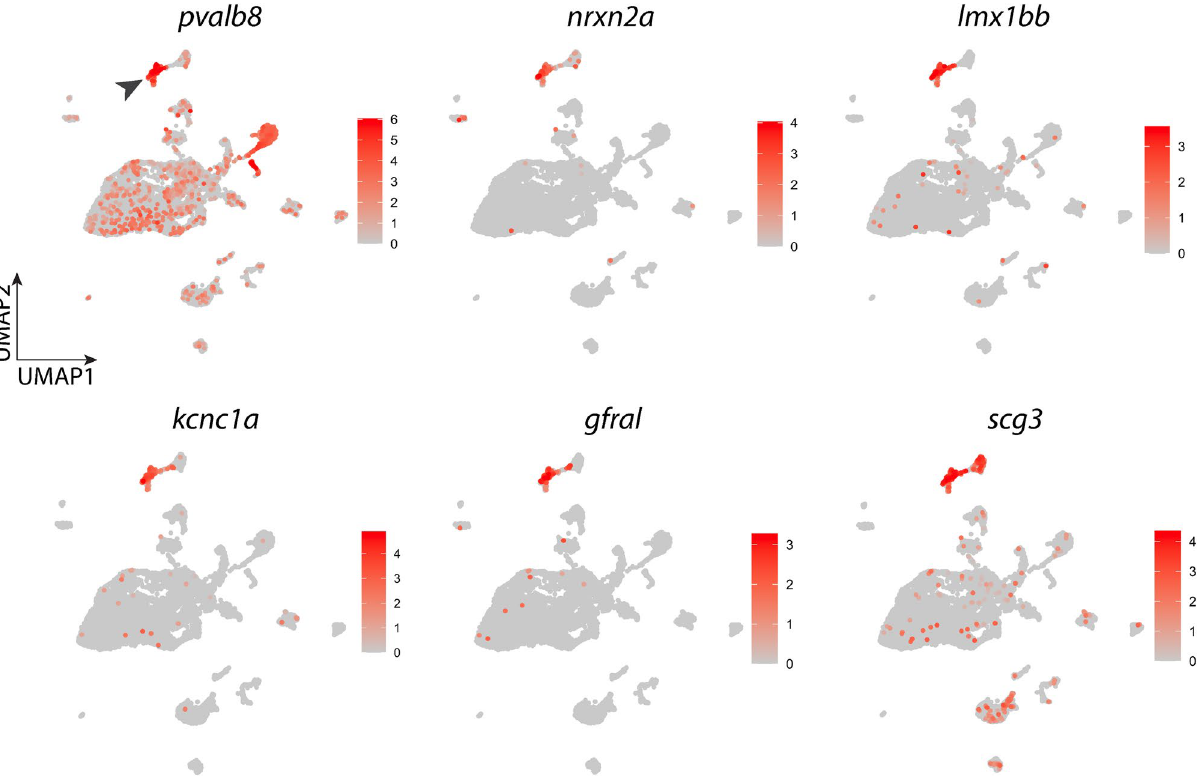
Figure 3. Expression of signature genes found in the neuron cluster. UMAP plots showing the log-normalized counts of selective genes that were highly differentially expressed in neurons. Colour intensity is proportional to the expression level of a given gene. Scales indicate relative gene expression. Arrowhead indicates significant expression in the neuron cluster. See text and Table 2 for gene